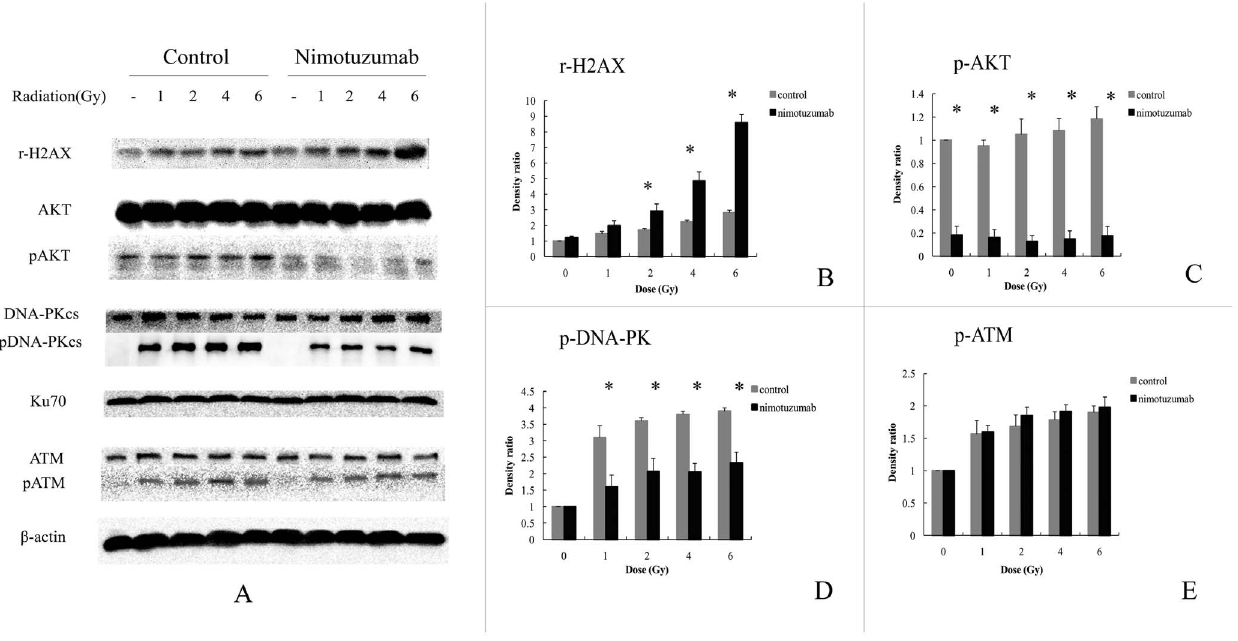
Figure 6. Effect of varying doses of radiation on DNA damage repair related proteins in A549 cells pretreated with nimotuzumab. (A) A549 cells pretreated with or without nimotuzumab were radiated with indicated doses. Two hours after radiation cells were harvested and lysed. The lysates underwent electrophoresis and were incubated with antibodies described in Figure 5. (B–E) Quantification of bands based on densitometric analysis. Each bar represents the mean 6 SD of three independent experiments. * indicates significant difference (P , 0.05).